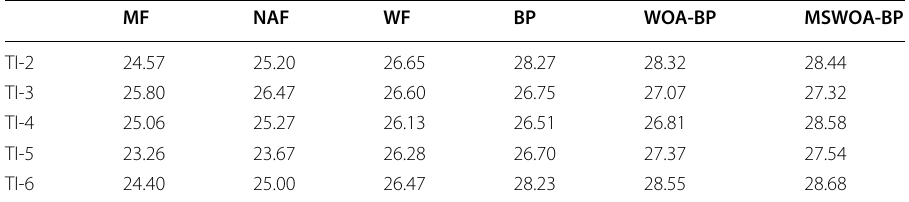
Table 7 PSNR with different denoising algorithms for traffic images